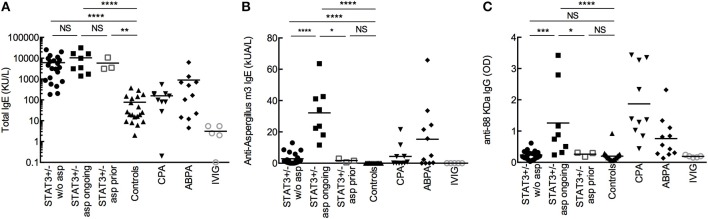
Total IgE (A), specific IgE (B), and IgG (C) against A. fumigatus. Comparison of sera from STAT3 deficient-patients (STAT3+/−, representing heterozygous mutation) without aspergillosis (w/o asp; n = 21), with ongoing aspergillosis (asp ongoing; n = 8) or with prior aspergillosis (asp prior; n = 3), with healthy controls (n = 20), CPA (n = 10), and ABPA (n = 11) patients, and patients receiving substitutive intravenous immunoglobulin (IVIG; n = 5). OD: optic density; *p < 0.05, ** p < 0.01, *** p < 0.001, and **** p < 0.0001 (the mean values are presented in the figures).